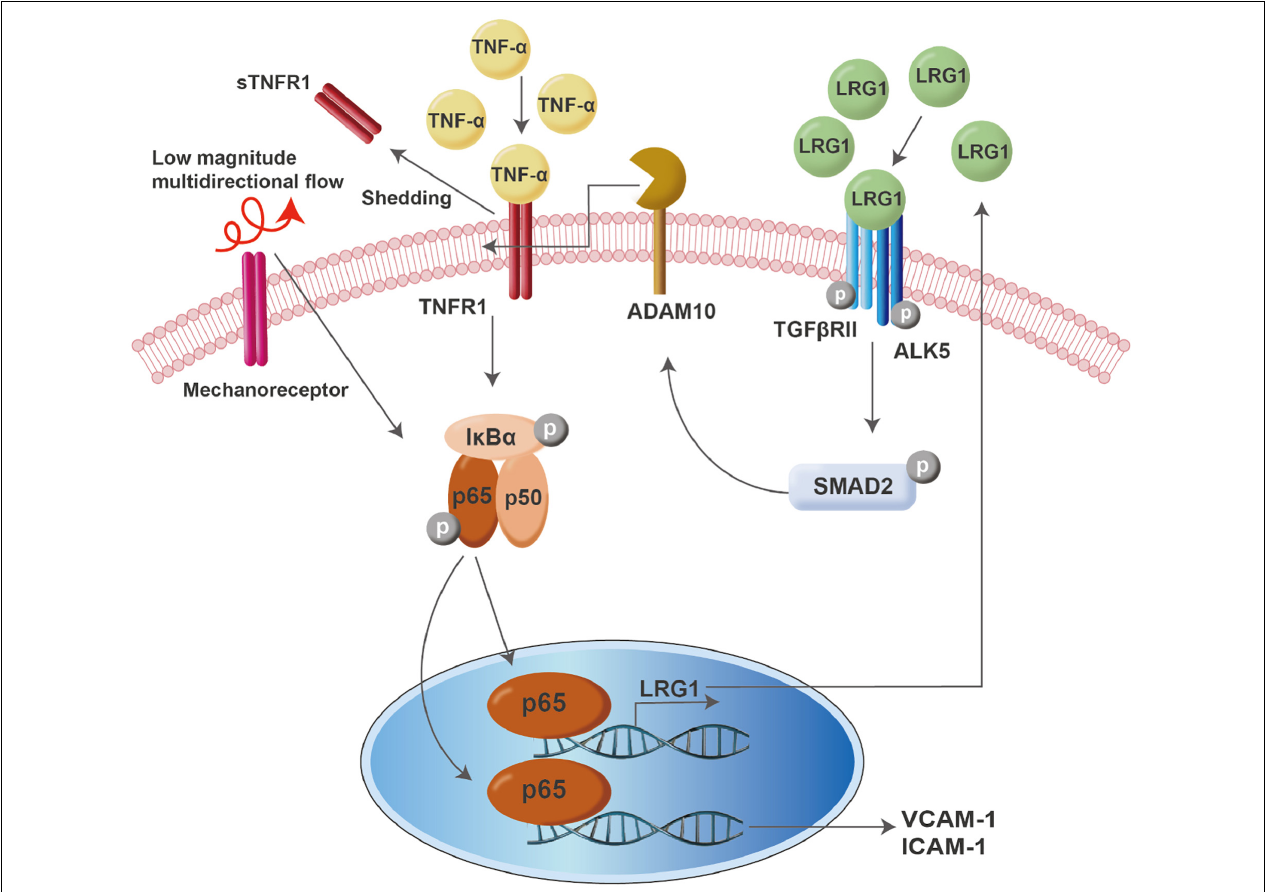
FIGURE 7 | Model of LRG1 activity in endothelial